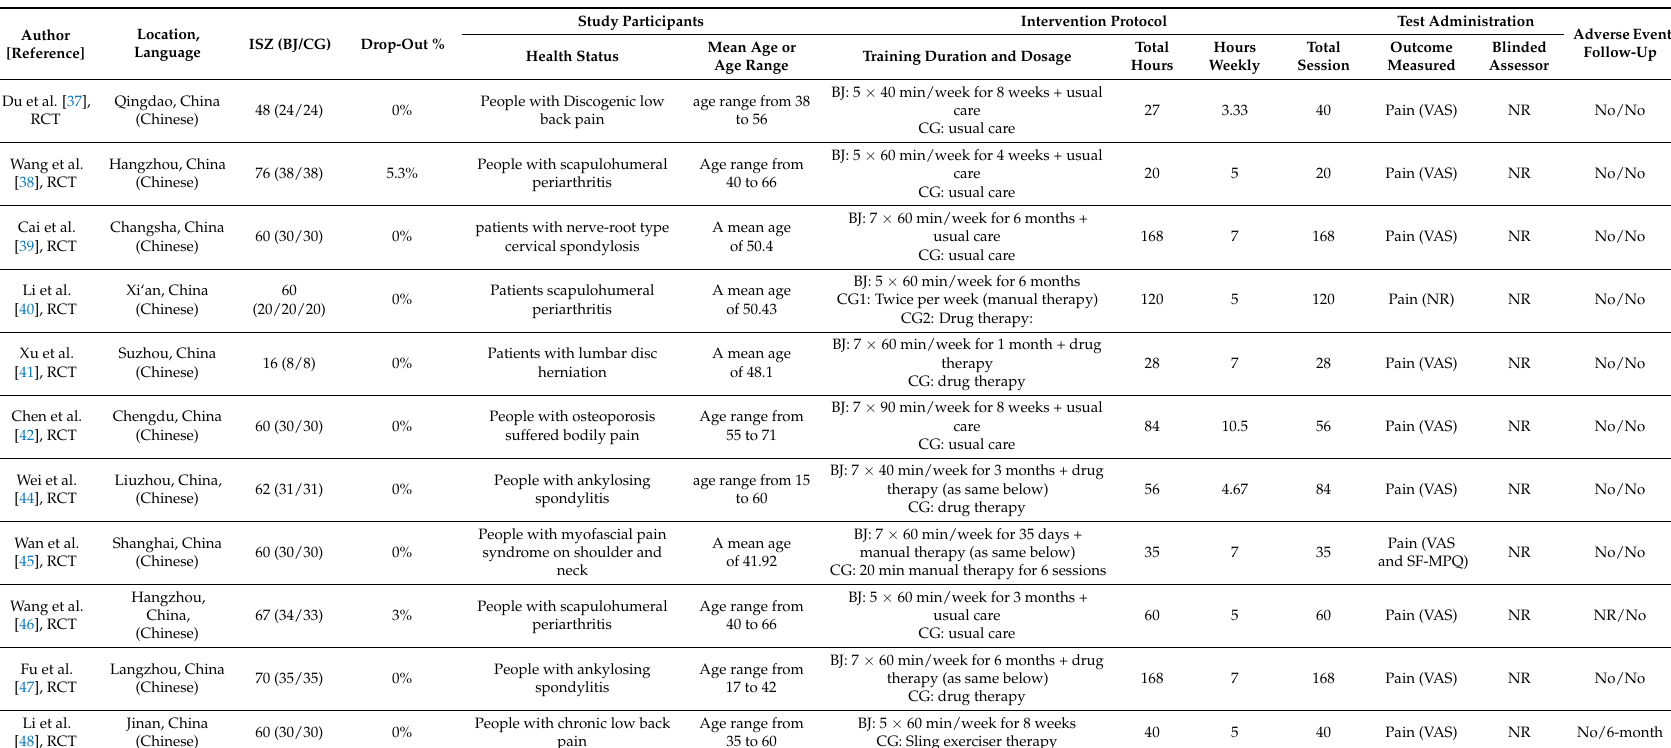
Table 1. Summary table relating to